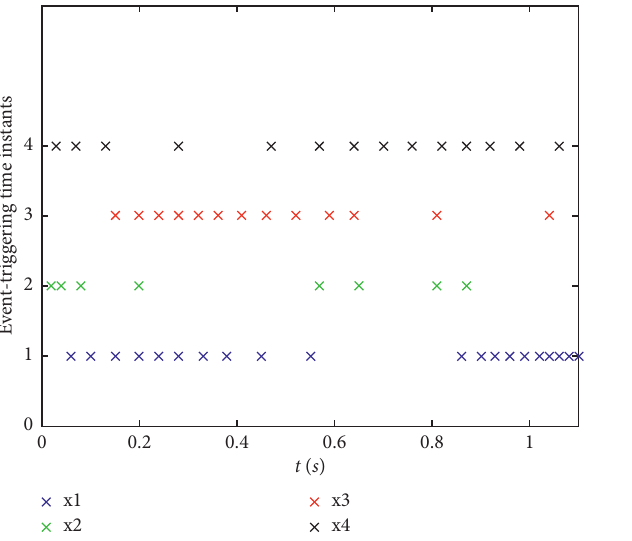
Figure 8: Event times instants for four agents in Theorem 3.